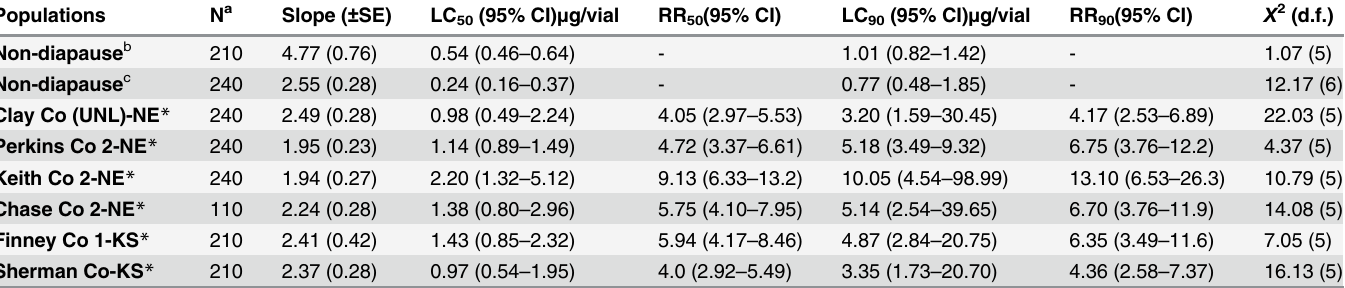
Table 2. Susceptibility ( ± 95% Confidence Interval) of western corn rootworm adults by contact to bifenthrin from field populations throughout Nebraska and Kansas, and from two non-diapause laboratory colonies. Resistance ratios compared with lowest non-diapause LC 50 ; bioassays con- ducted in